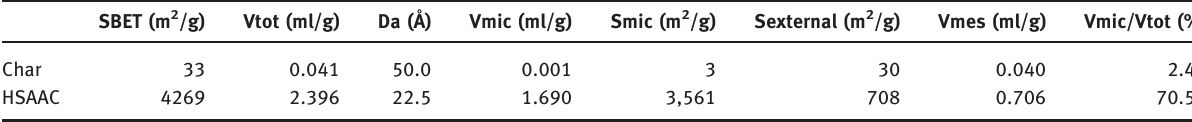
Table 7: Pore structural parameters of the char and